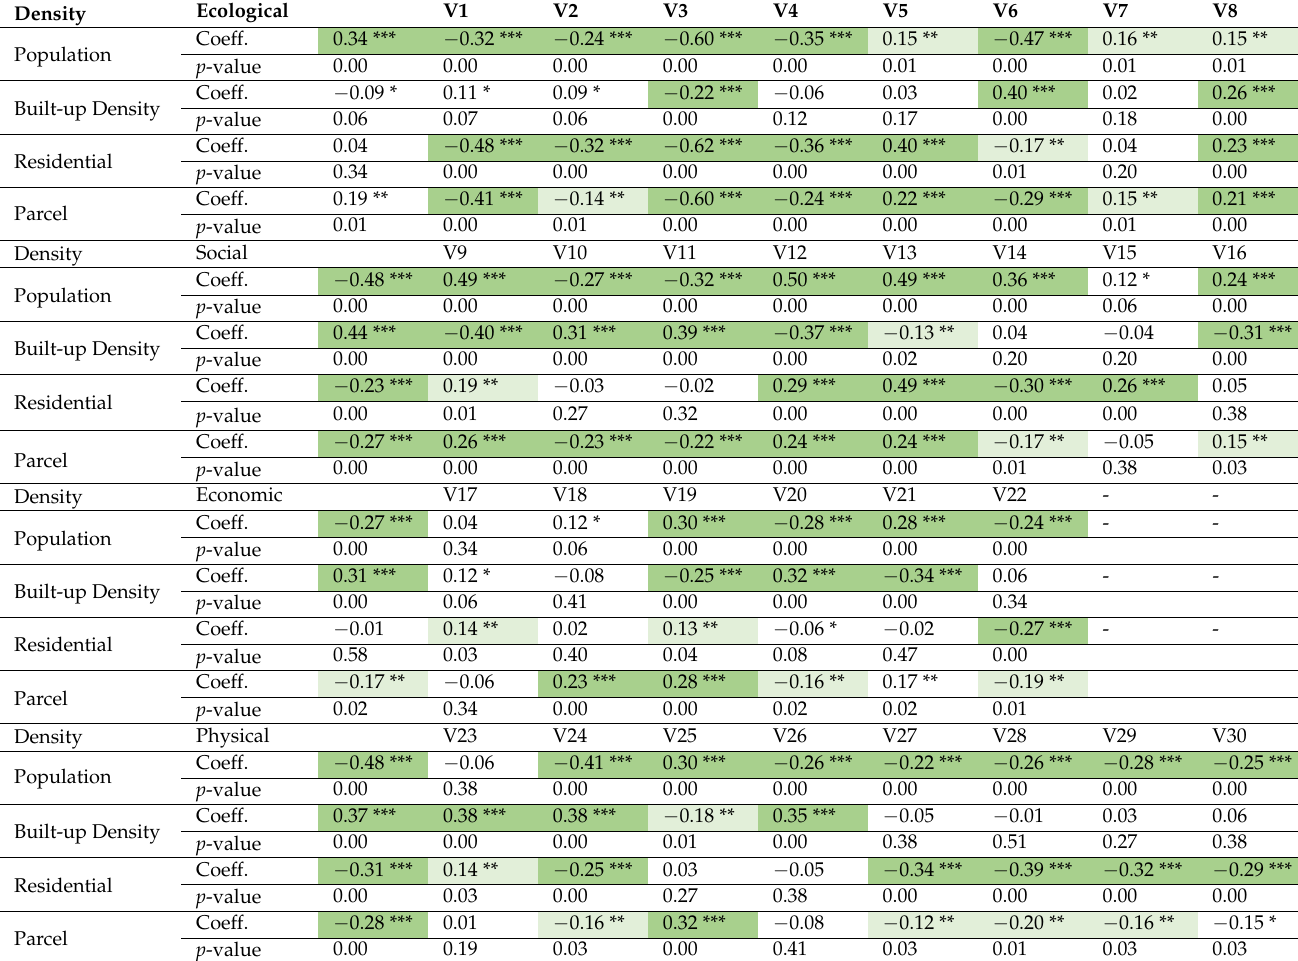
Table 4. Correlation between urban resilience and density